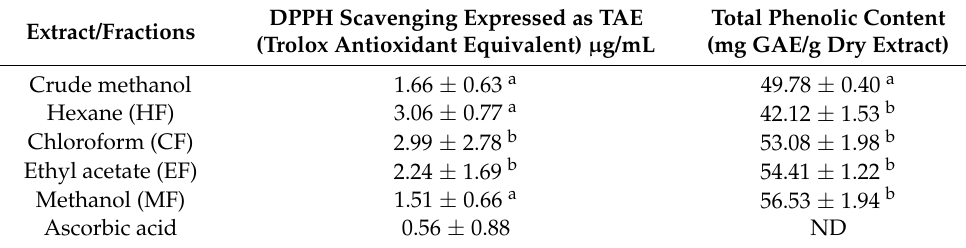
Total Phenolic Content (mg GAE/g Dry Extract)